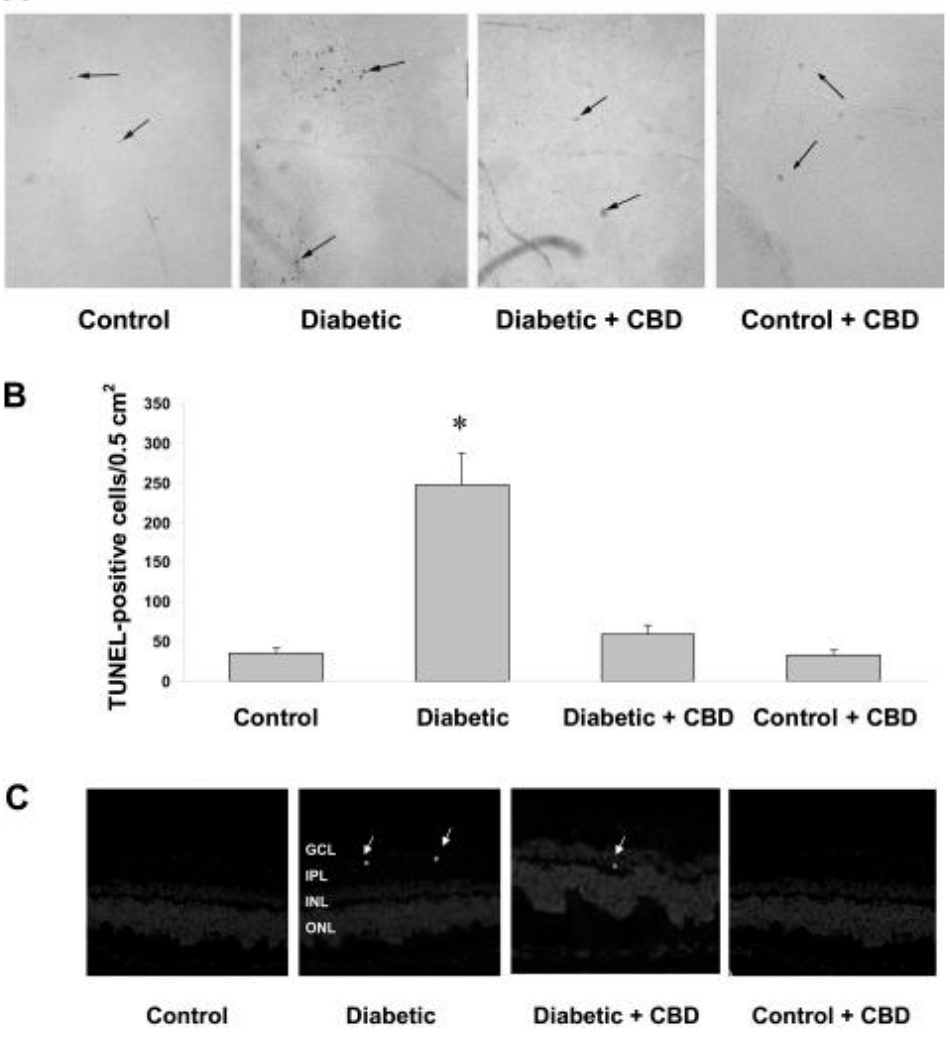
Figure 7. CBD exerted retinal neuroprotective effects in an experimental diabetes rat model. A terminal dUTP nick end labeling (TUNEL) assay was performed after 4 weeks of induced diabetes to detect retinal cell death by using horseradish peroxidase (HRP) detection (TUNEL-HRP). ( A ) Numerous TUNEL HRP-labeled cells (arrows) were detected in whole-mounted retinas from 4-week diabetic rats as compared with untreated controls and the CBD-treated group. ( B ) Total number of TUNEL HRP-positive cells counted in each retina, expressed per 0.5 cm2. The diabetic rats had significantly more TUNEL HRP-positive cells than the controls and the CBD-treated group (* p < 0.001; n = 5 to 6). Treatment with CBD (10 mg/kg every 2 days) blocked cell death in the diabetic retinas but did not alter the number of TUNEL+ cells in control rats. ( C ) A representative image shows the TUNEL labeling of frozen eye sections from the diabetic rats (4 weeks) in different retinal layers: ganglion cell layer (GCL), inner plexiform layer (IPL), inner nuclear layer (INL) and outer nuclear layer (ONL). TUNEL+ cells (arrows) were distributed mainly in the inner retinal layers. Original magnifications, × 100 ( A ). Reproduced from El Remessy et al.